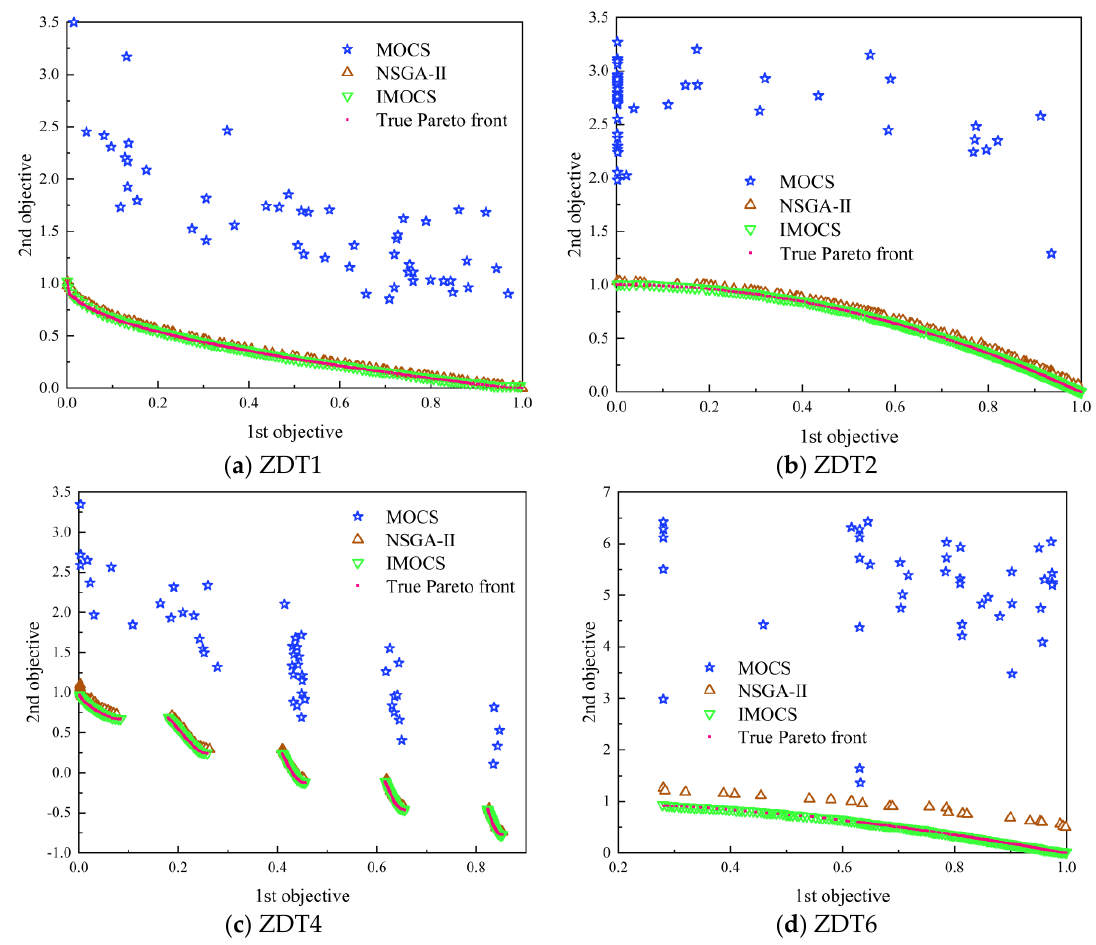
Figure 16. Comparison of test function optimization results.